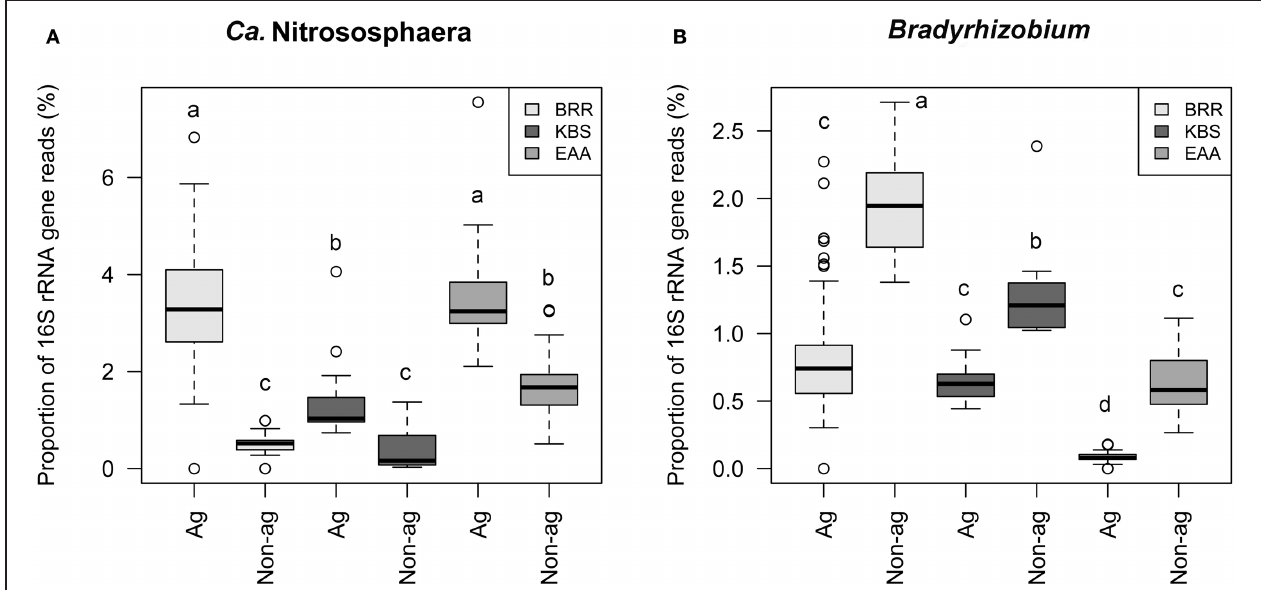
the 25–75th percentiles, the whiskers represent the 10–90th percentiles, the line inside the box represents the median, and the open circles represent the outliers. The same letter above the box indicates no significant difference between means by Duncan’s test at the 95% confidence interval.